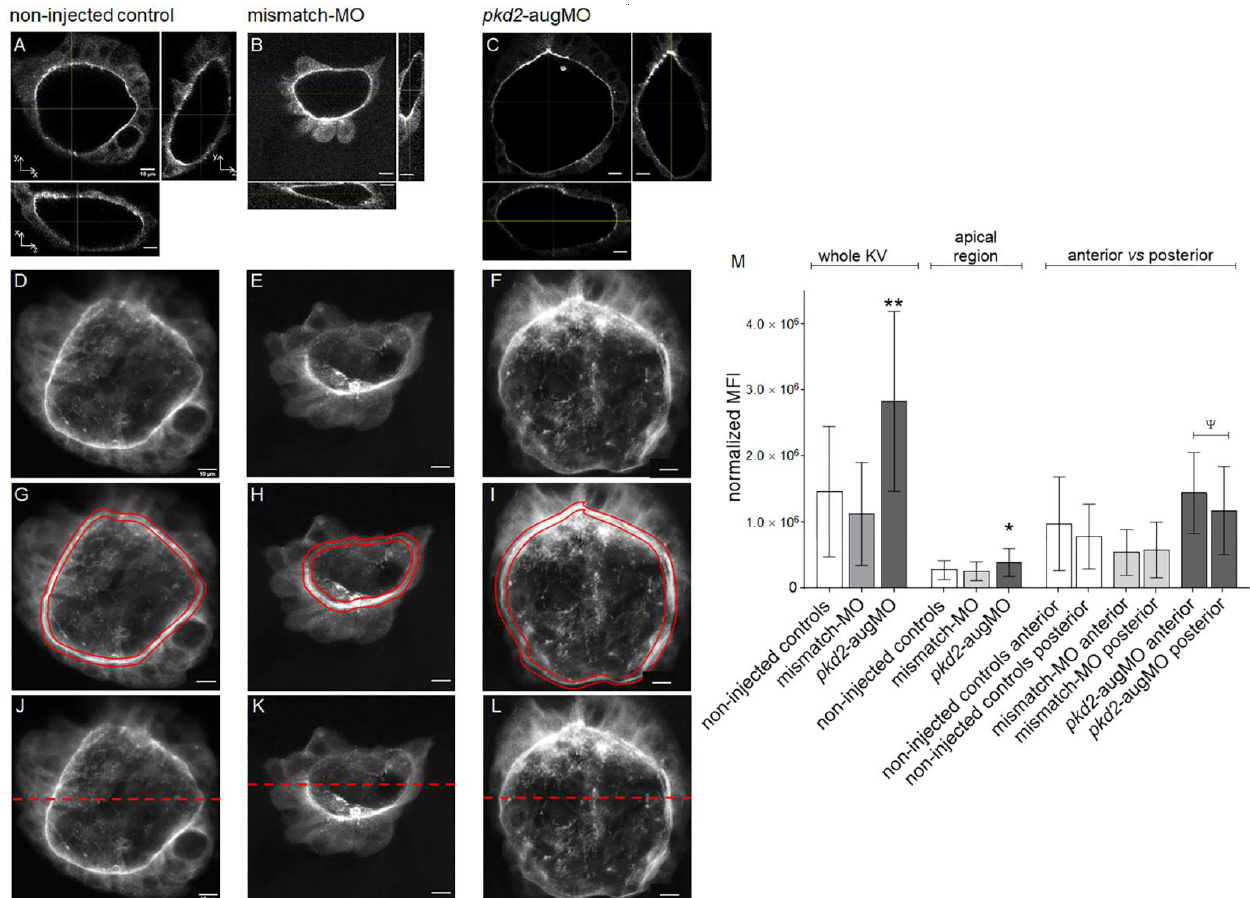
Figure 3. Estimated CFTR-GFP protein level in KVs of TgBAC(cftr-GFP)pd1041 embryos. ( A – L ) Confocal live-scan analysis. The middle plan along the xy axis and its respective orthogonal views (along xz and yz axes) and the image resulting from the sum of all slices of the confocal live-microscopy scan of the whole KV are, respectively, shown for the most representative non-injected control ( A , D ), mismatch-MO ( B , E ), and pkd2 -knockdown ( C , F ) embryos. ( G – I ) The apical region of the KV cells of ( D , E , F ) is highlighted in red. ( J – L ) anterior (upper) versus posterior (lower) parts of the KV are highlighted. ( M ) MFI determined for the whole KV, KV cells’ apical region and KV’s anterior versus posterior regions of non-injected control ( n = 15), mismatch-MO ( n = 6), and pkd2 -knockdown ( n = 20) embryos. Median averages ± SD are indicated. t -test was used to compare whole KV MFIs of pkd2 -augMO versus non-injected embryos (samples with normal distribution and equal variances), ** p < 0.01. Mann–Whitney test was used to compare the MFIs of KV cells’ apical region of pkd2 -augMO versus non-injected embryos (samples that did not passed normality tests), * p < 0.05. Paired t -test was used to compare the anterior versus posterior MFIs for each situation (all samples having normal distribution), ψ p < 0.05. Scale bars: 10 μm.